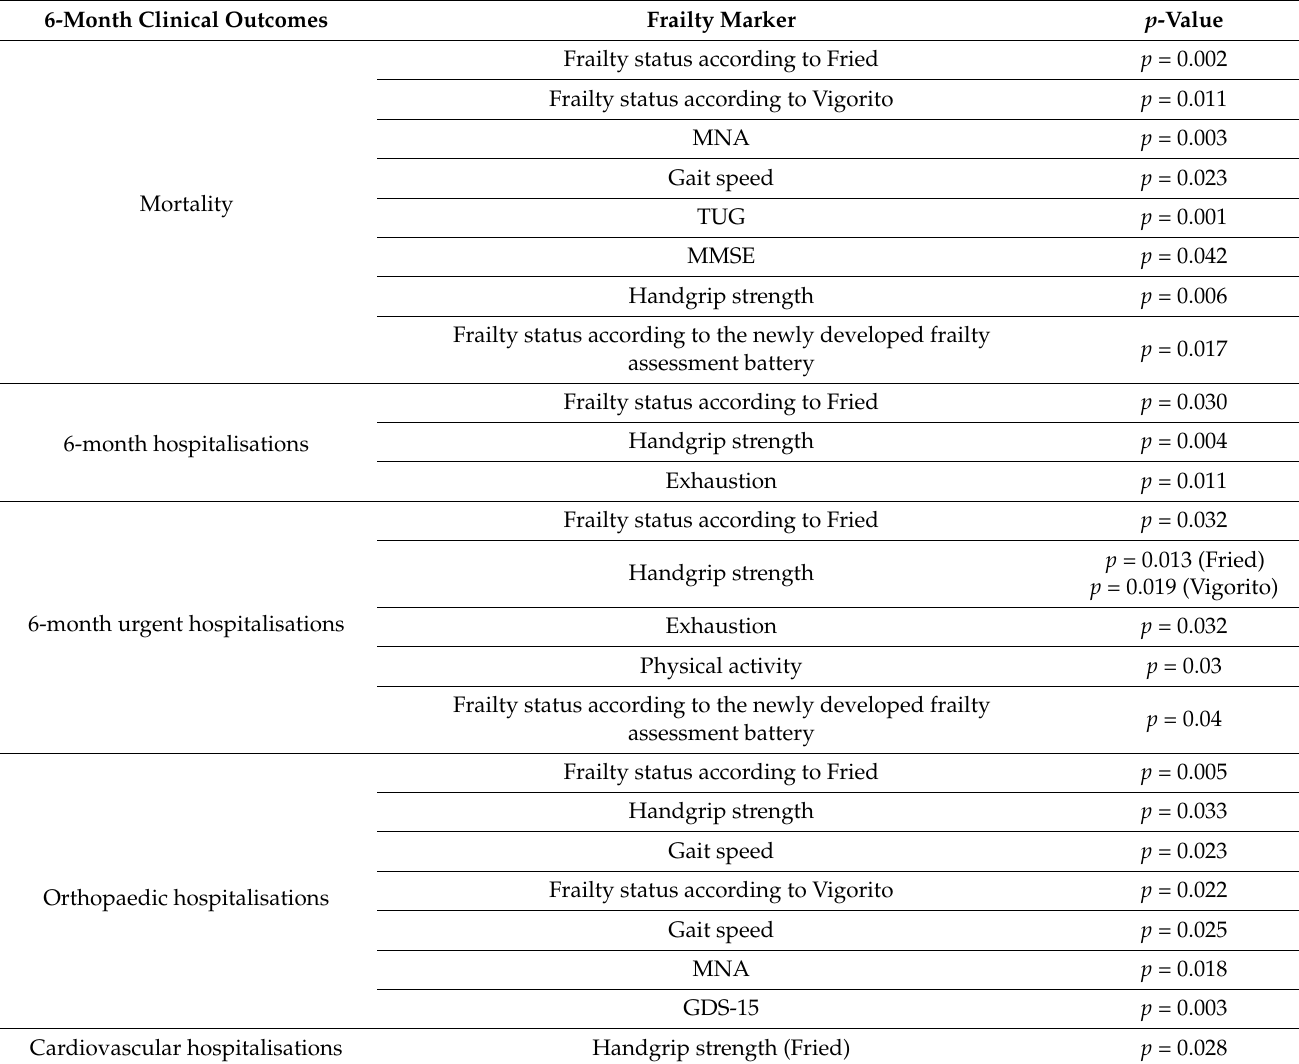
Table 6. Significant associations between markers of frailty and 6-month clinical outcomes. Frailty